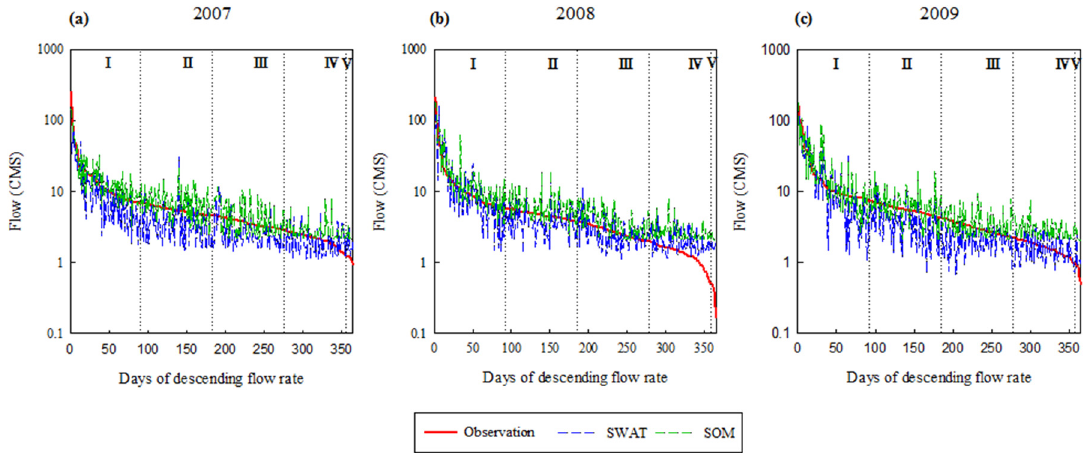
Figure 4. Data imputation results of 350 missing flow data for the SWAT, ANN, and SOM models. Four line graphs represent the observation (red), SWAT (blue), ANN (purple), and SOM (green), while the bar graph at the top is the daily precipitation amount of the missing flow data. 3.3. Comparison of Flow Duration Curve Q95, Q185, Q275, and Q355 from FDC indicate the criteria for averaged-wet flow, normal flow, low flow, and drought flow, respectively [42]. This study separated FDC into five sections based on the flow indices in an attempt to compare the model performances during low-flow and high-flow separately. Figure 5 portrays the FDC of Samho station from 2007 to 2009 and shows the streamflow